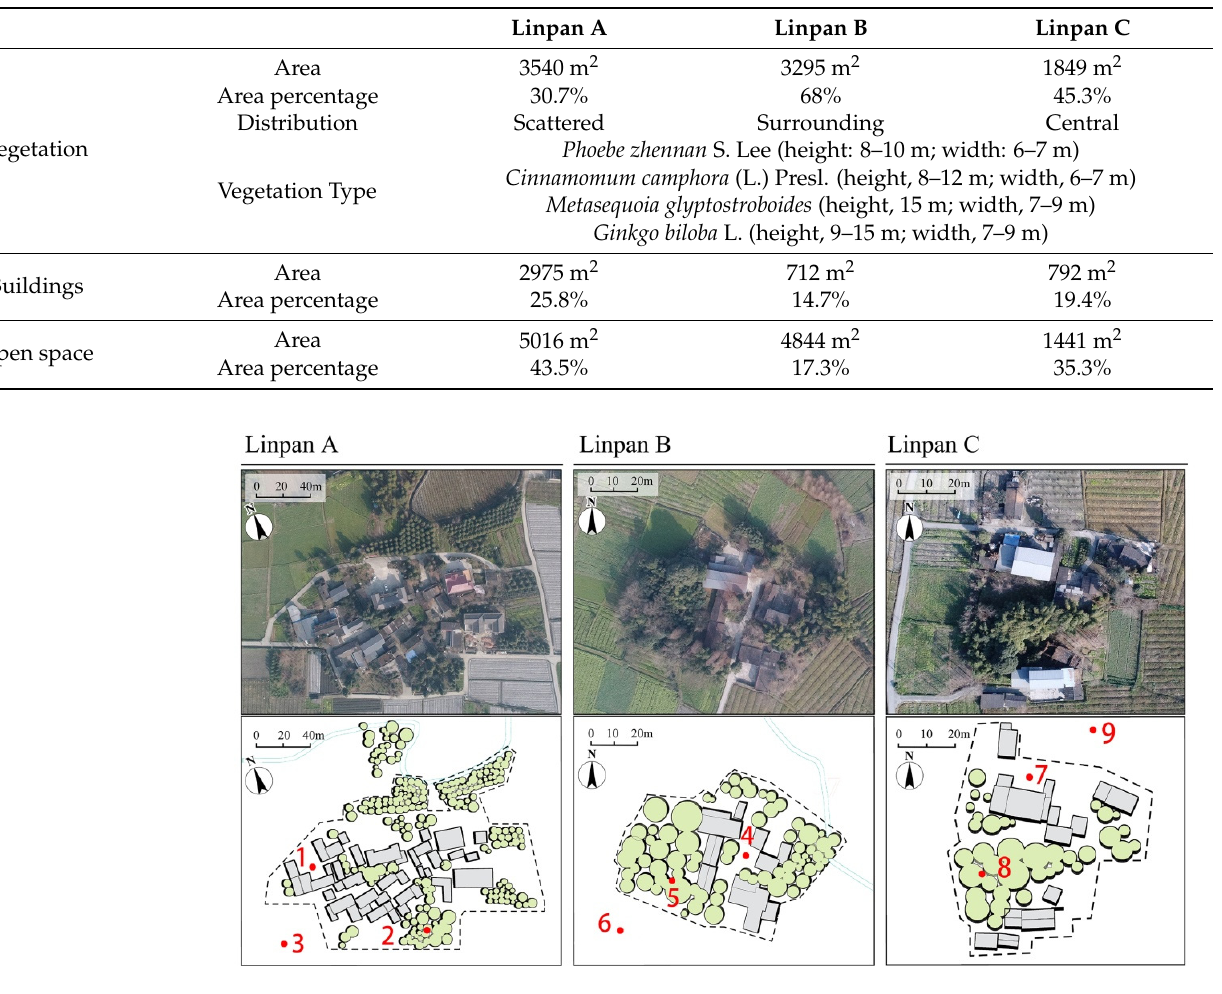
Figure 5. Measuring points distribution of Linpan A, B, and C.